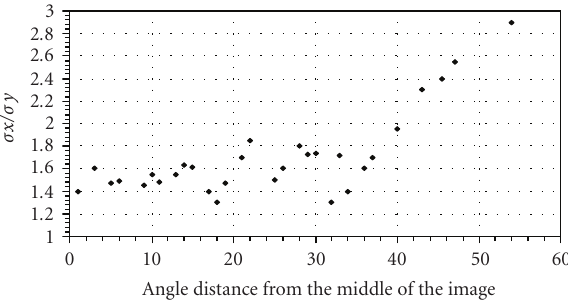
Figure 10: Ellipticity (an ideal PSF deformation) of stars’ profiles as a function of angle distance from the middle of an all-sky image. magnitude can reach 15 over a smaller (10 × 10 degrees) FOV. The system can be very easily duplicated to